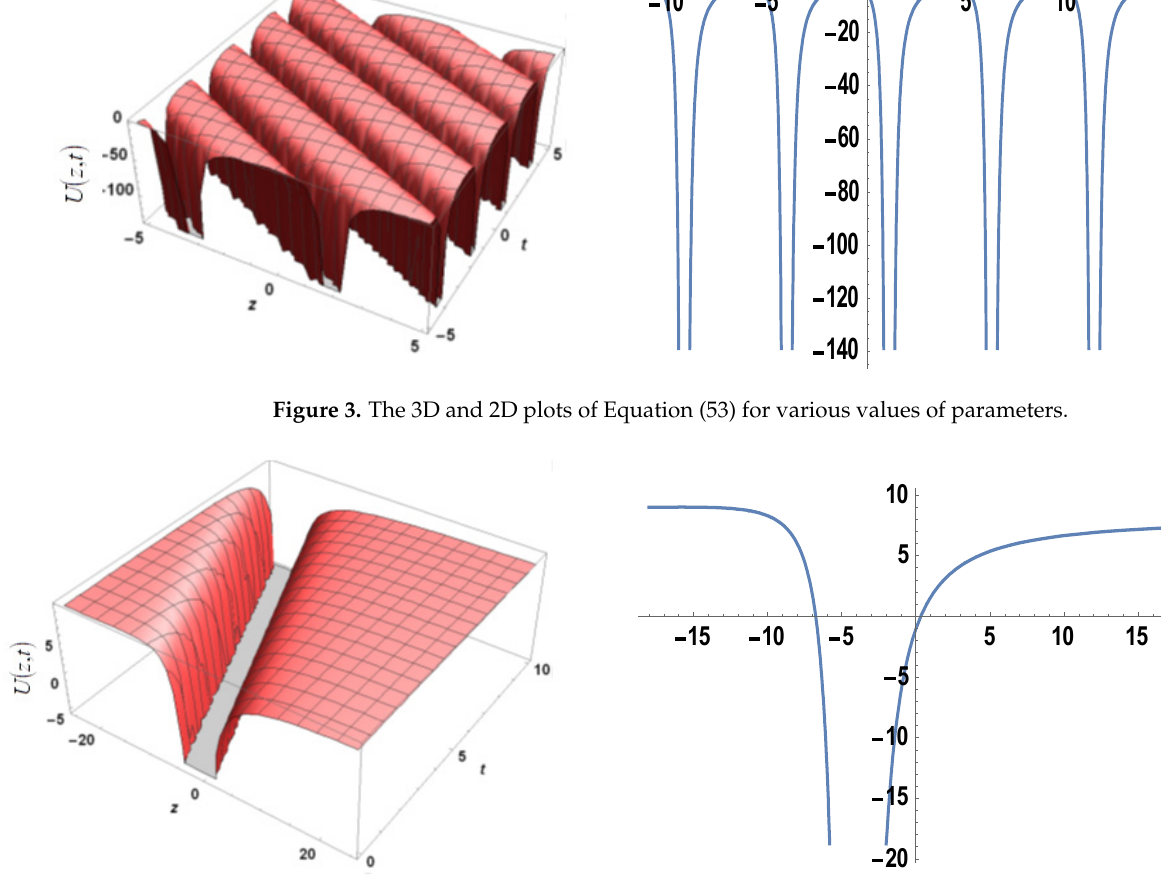
Figure 5. The 3D and 2D plots of Equation (55) for various values of parameters.